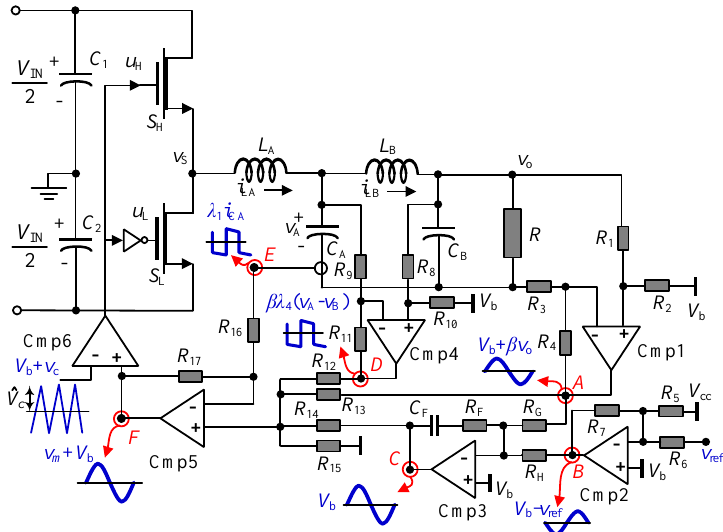
Figure 5. Circuit realization of FFDISM controller with i CA feedback (CNRL2).